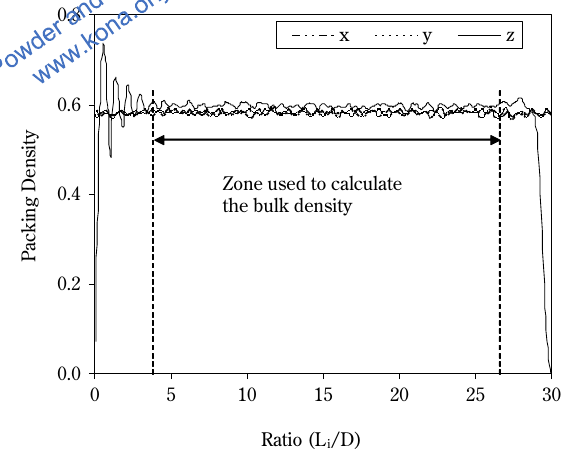
Packing density profiles along X, Y and Z directions in a cubic simulation box with periodical boundary conditions in the lateral (X and Y) directions. The bulk density is cal- culated by taking the average over the central part in the profiles to avoid wall effect and the influence of free sur- face. L